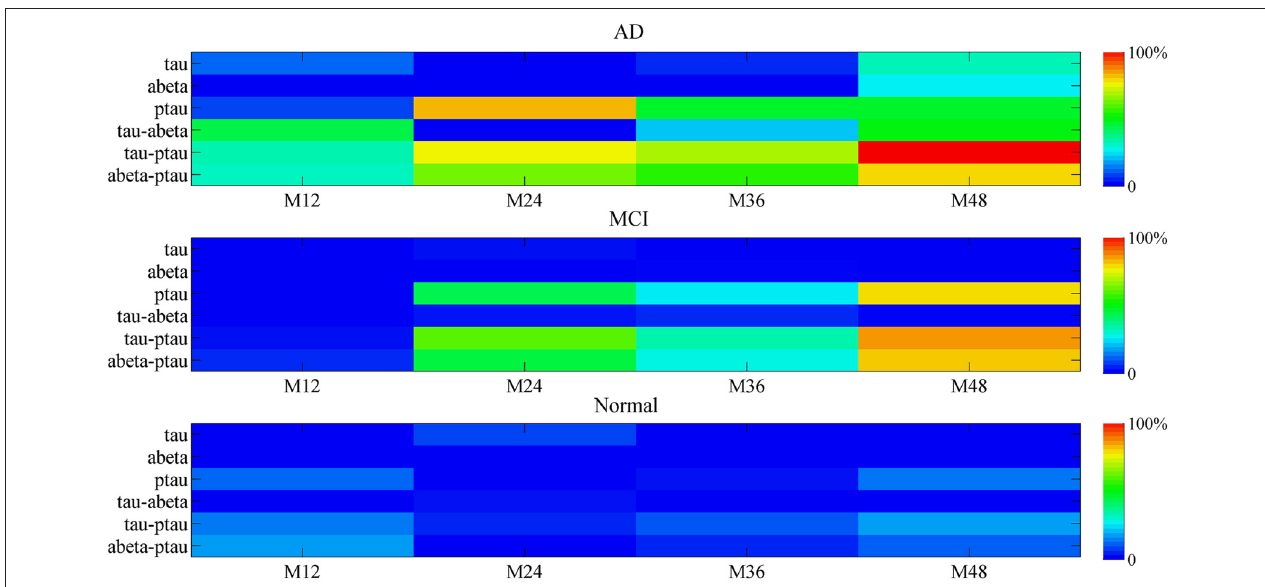
FIGURE 9 | The percentage contribution to mini network disruption of the markers. Color-coded scale is used to present the percentage contribution to mini network disruption of the markers in this plot. The joint contribution of tau and P-tau as well as P-tau and A β both are potential vital factors of disease.